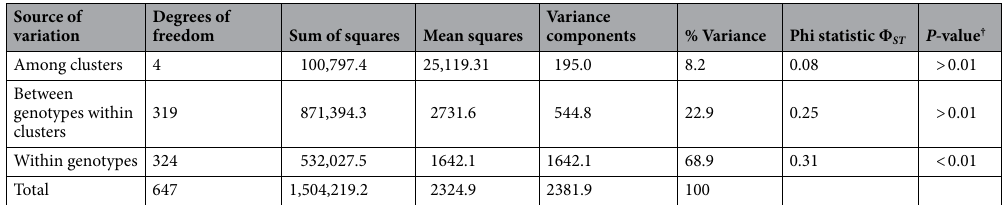
Table 3. Hierarchical analysis of molecular variance (AMOVA) between five geographic clusters of S. famelica and S. eriocephala identified by Bayesian analysis . † Significance tests were performed with 999